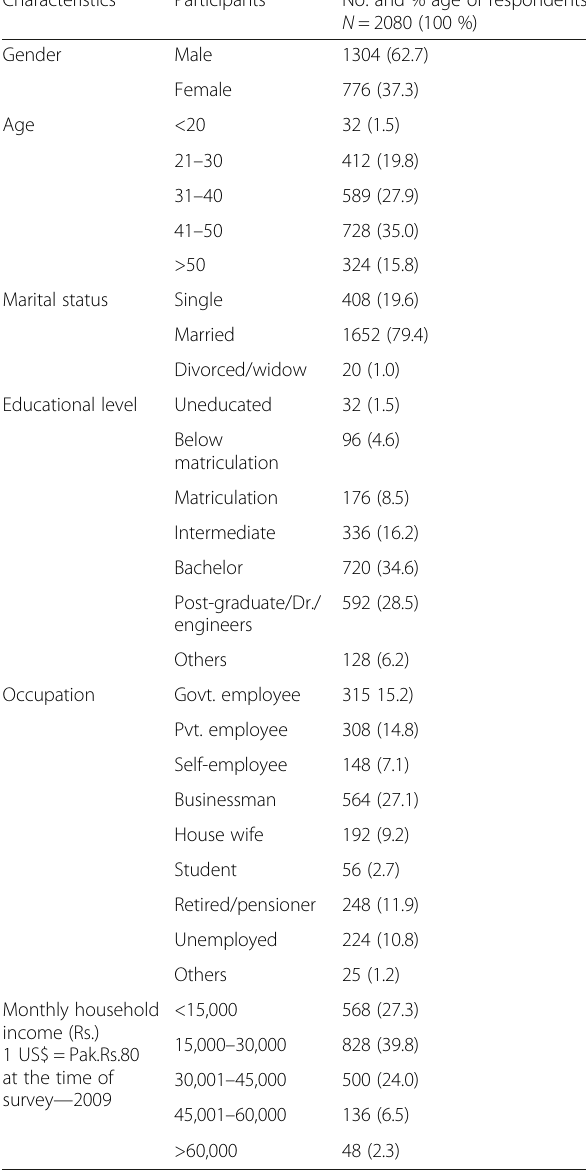
Table 3 Socioeconomic characteristics of the respondents